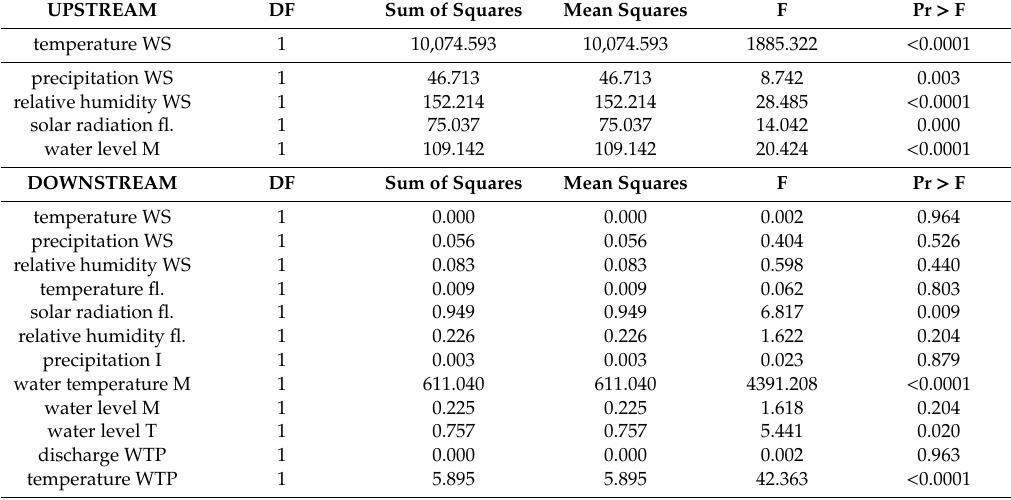
Table 2. Analysis of covariance (ANCOVA) of Suceava River water temperature upstream or downstream (dependent variable) versus other parameters (explanatory variables) - type III sum of squares